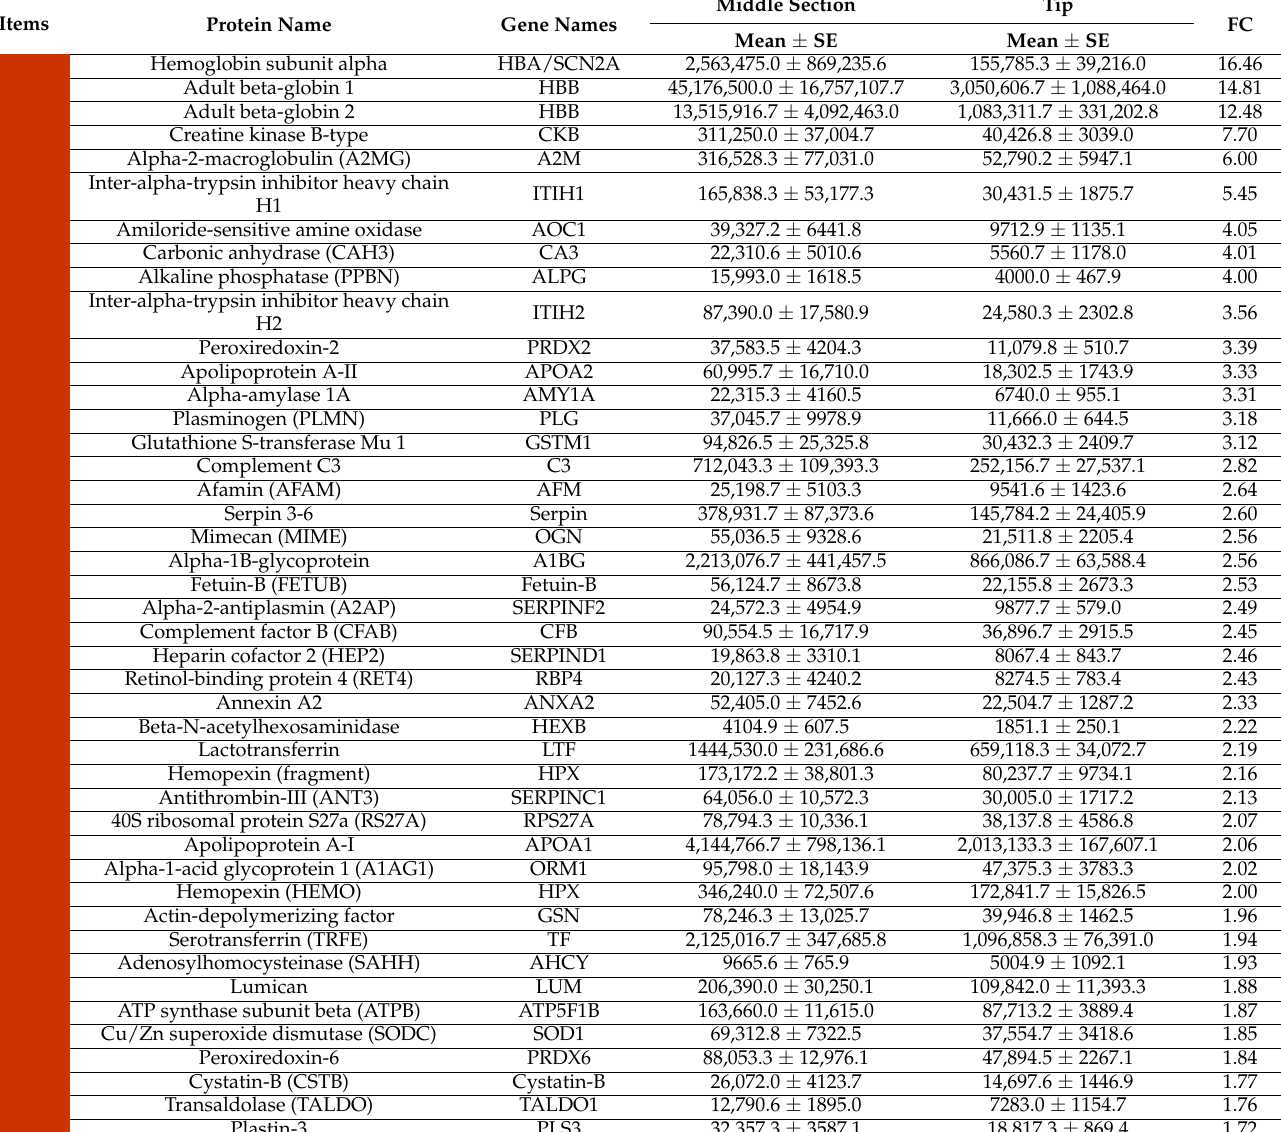
Table 1. List of differential abundant proteins (mean value ± standard error of mean) of the antler samples of red deer ( Cervus elaphus ) from a native Iberian population of the two locations (tip and middle), gene names and fold change (FC) between both